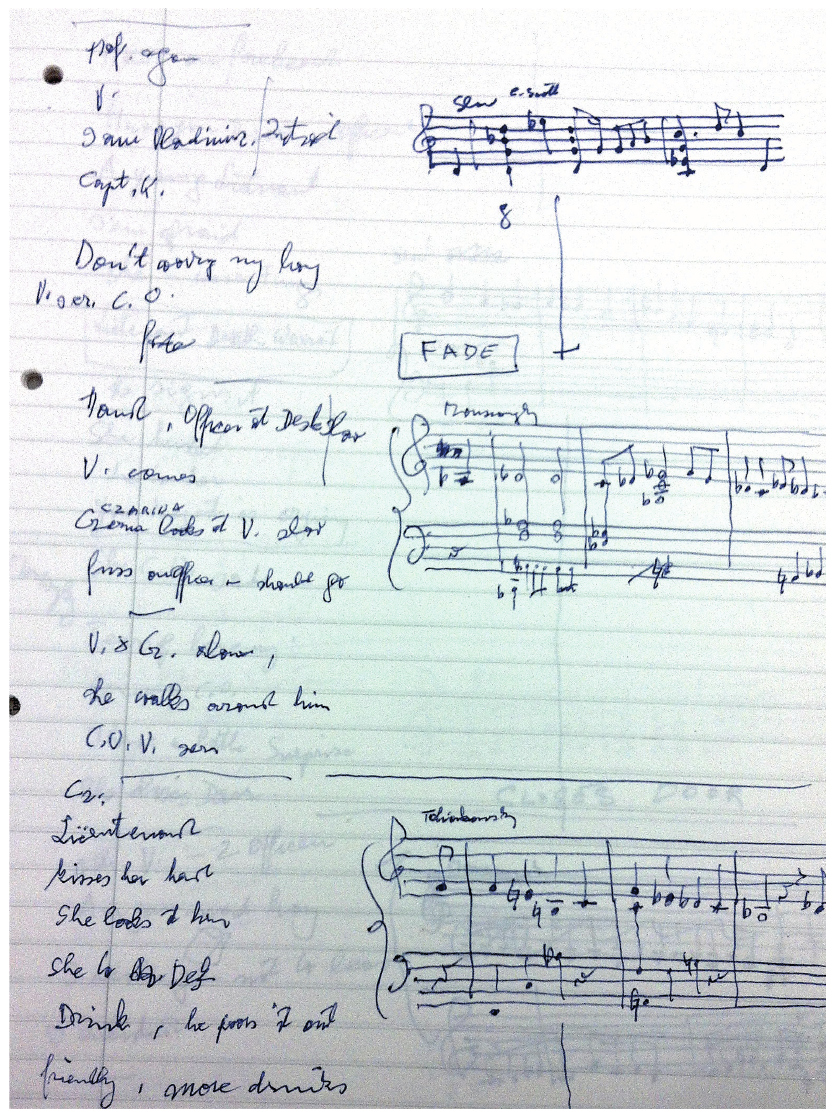
Fig. 2 Spotting session notes for The Eagle (1925) including music incipits (Arthur Kleiner Collection of Silent Movie Music, Films, EA-FI, Box 6, University of Minnesota